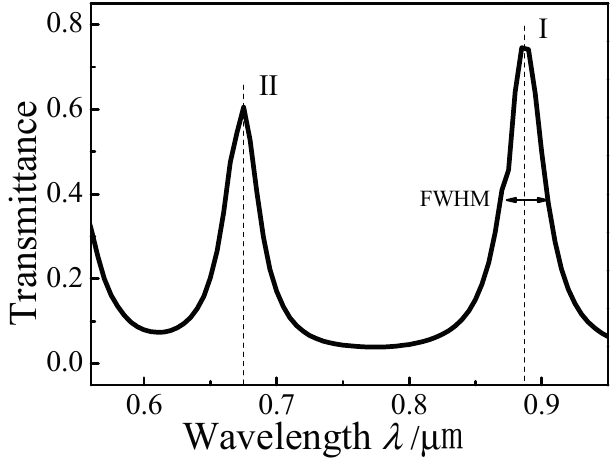
Figure 2. Transmission spectrum of the MIM waveguide-coupled ring resonator.